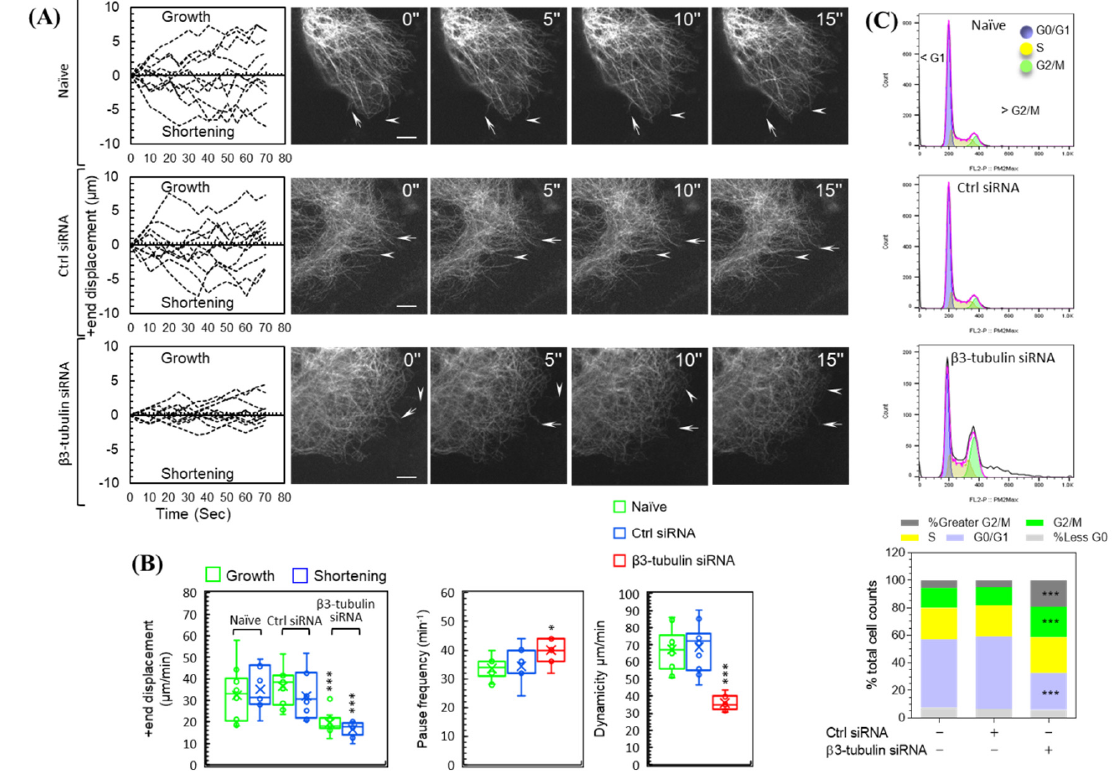
Figure 2. β 3-tubulin knockdown suppresses microtubules (MTs) dynamics and disrupts cell cycle in A375 cells. (Panel A, right) Micrographs of EGFP-MAP-4-labeled MTs in naïve, ctrl-, and β 3-tubulin siRNA-treated A375 cells. Images were acquired every 5 s and show MTs +end growth (arrows) and shortening (arrowheads). Original magnification ×1000 (bar, 5 μ m). (panel A left) Traces of ten representative MTs +end displacements (growth and shortening) measured over a period of 75 s. Quantification of dynamic growth and shortening (panel B, left), and pause frequency (panel B, middle) and dynamicity (panel B, right). (C) Flow cytometric histograms (top panels), and cell cycle growth phase distribution analysis (bottom panel) demonstrate the effect of β 3-tubulin knockdown on cell cycle in A375 cells. Statistical significance between naïve, ctrl-, and β 3-tubulin-siRNA groups was determined using an ANOVA with Tukey’s correction for multiple comparisons. n = 10 (MTs analysis) or = 6 (cell cycle analysis), *** p < 0.001, and * p < 0.05 versus naïve cells.